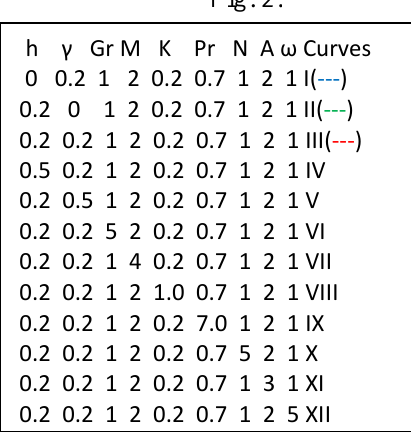
Table 1. Sets of parameter values plotted in Fig.